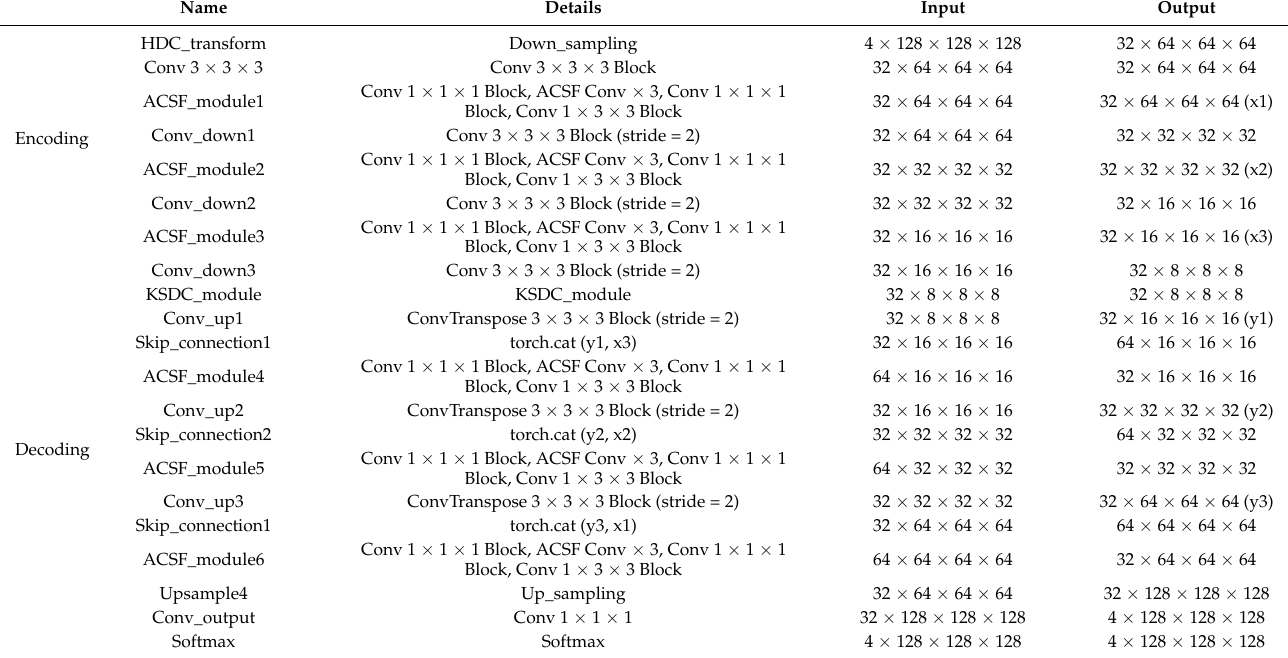
Table 1. The network structure of MVKS-Net, where Conv 3 × 3 × 3 (1 × 1 × 1, 1 × 3 × 3)